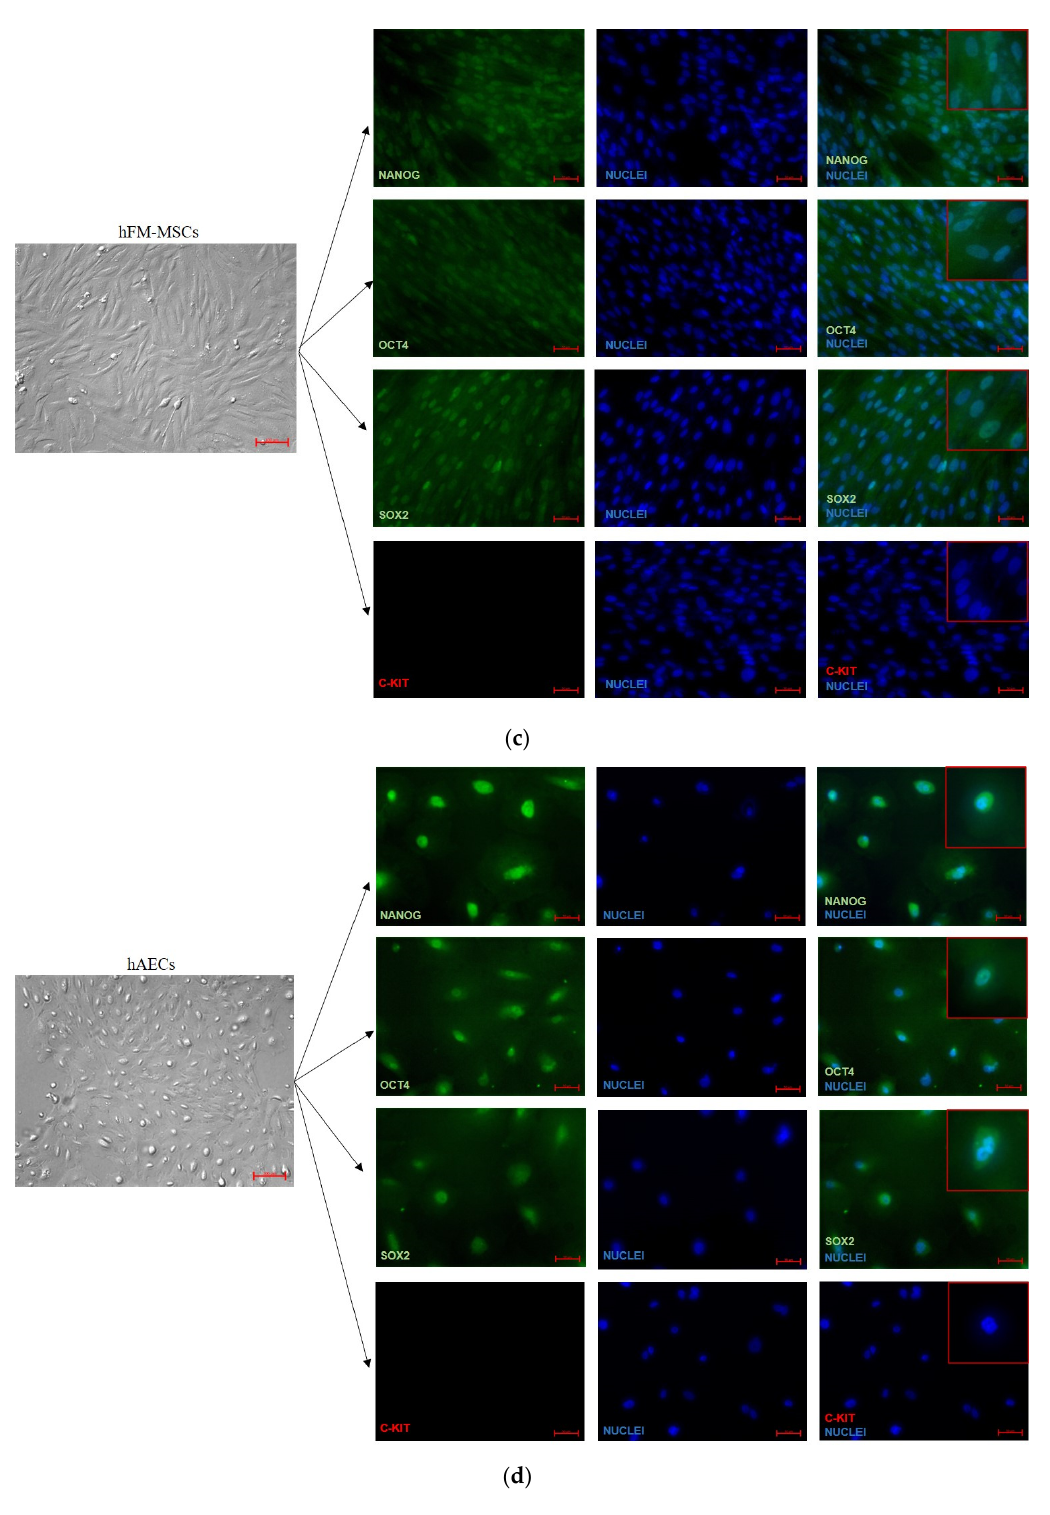
Figure 4. Immunofluorescent analysis for the NANOG, OCT4, SOX2, and C-KIT expression in hiPSCs and perinatal SCs. NANOG, OCT4, SOX2 (green fluorescence), and C-KIT (red fluorescence) detection in ( a ) hiPSCs, ( b ) human amniotic fluid SCs (hAFSCs), ( c ) fetal membrane mesenchymal stromal cells (hFM-MSCs), and ( d ) human amniotic epithelial cells (hAECs). The nuclei were counterstained with DAPI (blue). Brightfield images (in grey) highlight the different morphology of the cell populations. The cells were observed with AxioVert A1 using plasDIC-plan neofluar. Original Magnification: brightfield: 10 × ; Fluorescence: 20 × ; inset: 40 × . Scale bars: brightfield images: 100 µ m; fluorescence images: 50 µ m. The images are representative of 5 independent